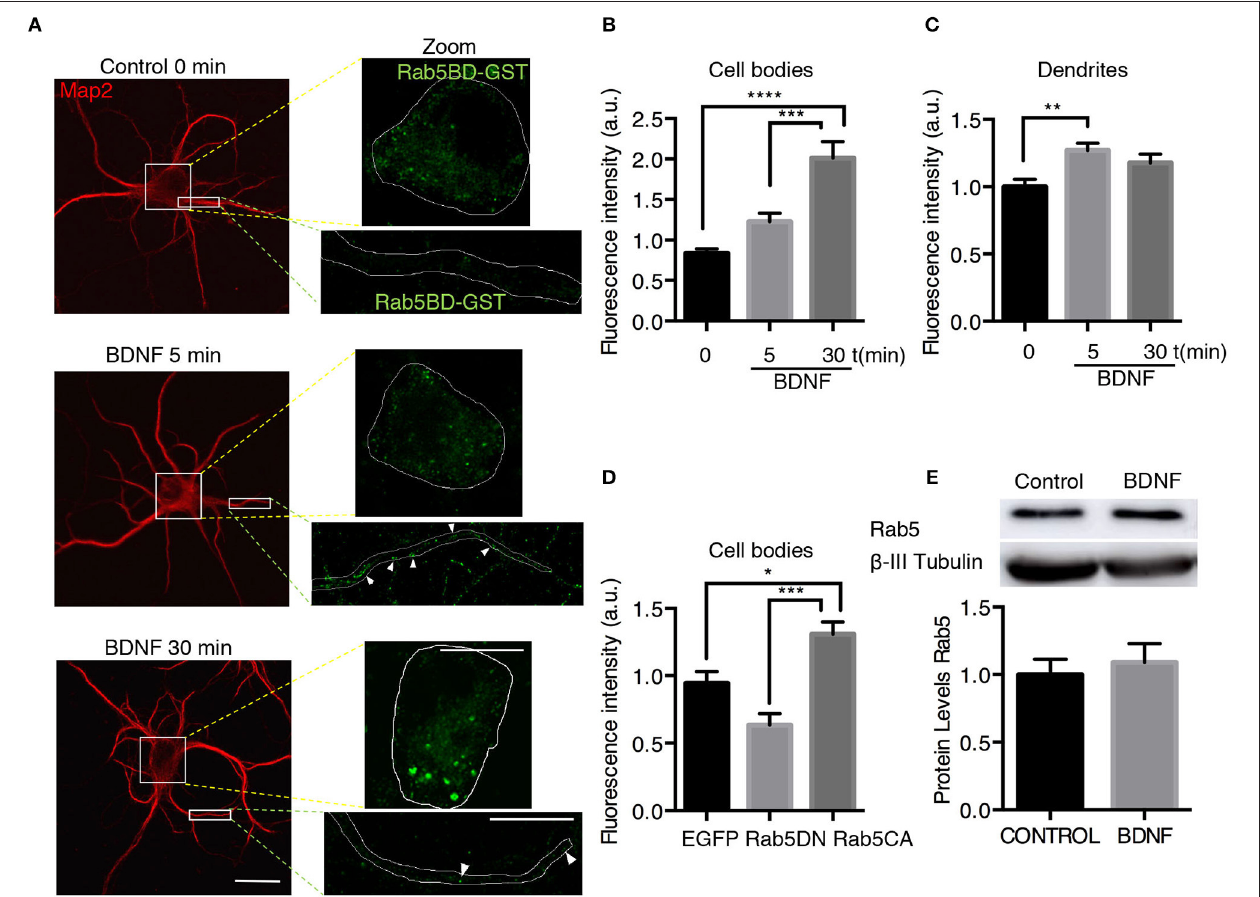
FIGURE 6 | BDNF increases the activity of Rab5. (A) Neurons were nonstimulated (control time 0min) or stimulated with BDNF for 5min (BDNF 5min) and 30min (BDNF 30min). Representative image of MAP2 immunostaining (red) and Rab5BD-GST (green). The white box indicates the region shown in the amplified photos of the cell body in the left panel and the dendrite shown in the right panel. Scale bar, 10 µ m. (B) Quantification of fluorescence intensity in the cell body. (C) Quantification of fluorescence intensity in primary dendrites of control neurons and neurons treated for 5 and 30min with BDNF. The results for the soma and dendrites were normalized to the values of control neurons (time 0min). A total of 28–29 cell bodies and 66–87 dendrites were included from 4 independent experiments. (D) Quantification of fluorescence intensity in the cell bodies of 7 DIV neurons transfected with EGFP, EGFP-Rab5DN, or EGFP-Rab5CA. The results are expressed as the mean ± SEM. * p < 0.05; ** p < 0.01; *** p < 0.001; **** p < 0.0001 by ANOVA with Bonferroni’s posttest. (E) The Rab5a and ß-III tubulin levels of hippocampal neurons (9 DIV) stimulated with BDNF for 30min. Lower part, quantification of the Rab5 levels of three independent experiments. The results are expressed as the mean ± SEM by Student’s t